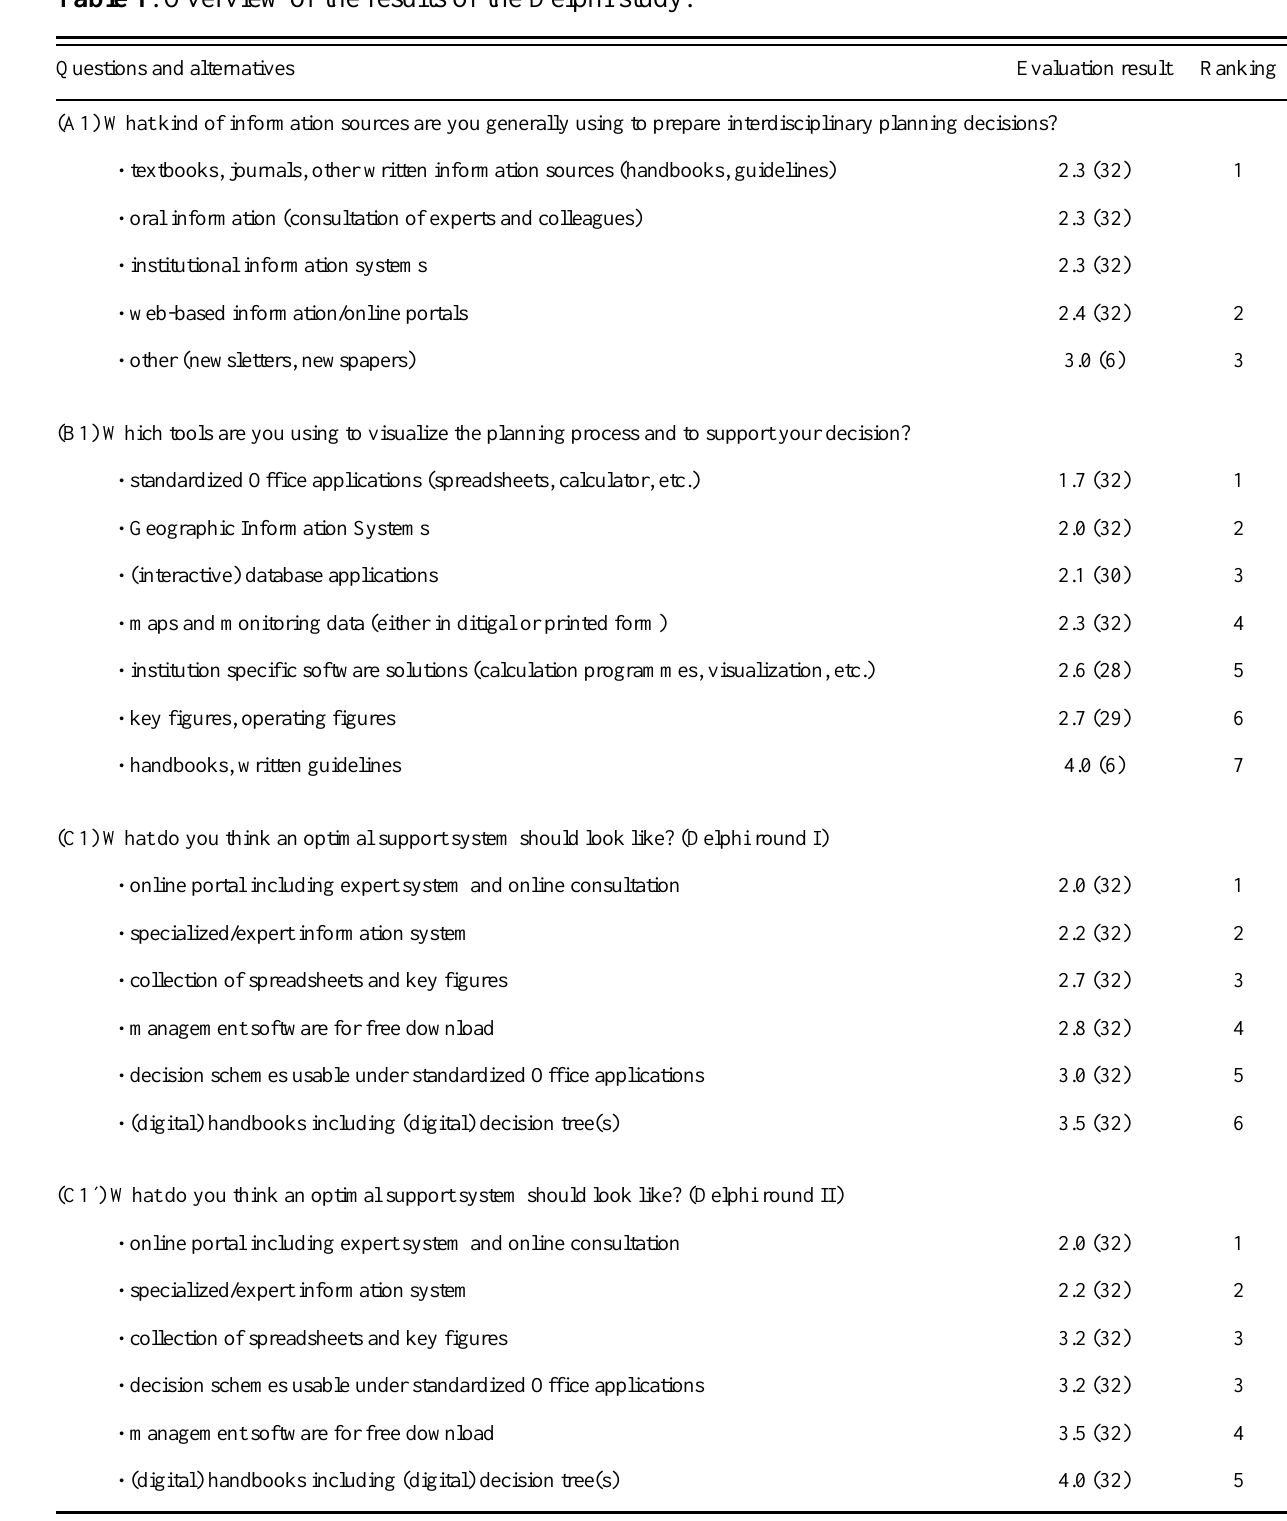
Table 1 . Overview of the results of the Delphi